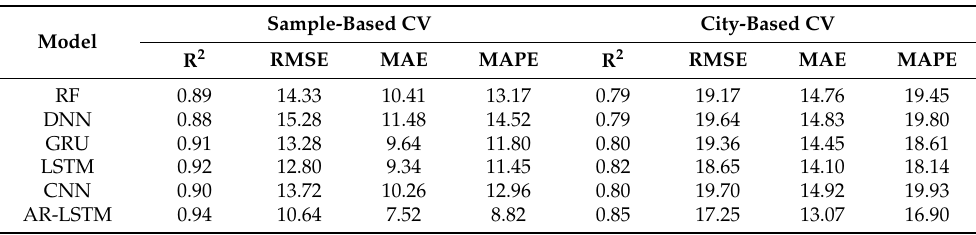
Table 1. Performance of various models in sample-based CV and city-based CV. The bold is used to emphasize the best results.